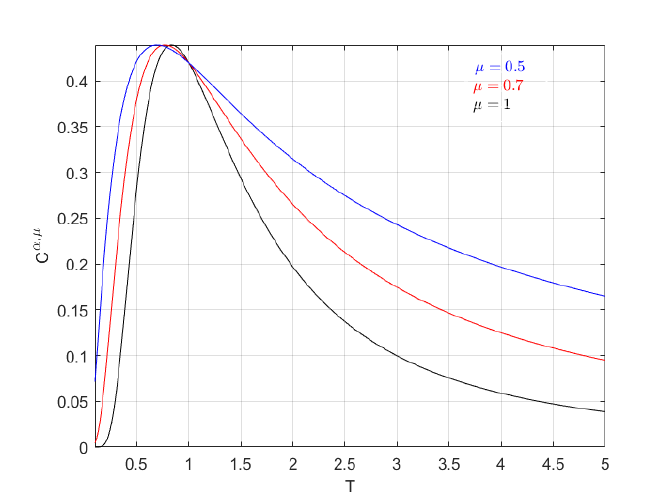
Figure 4. Graph shows the fractal heat capacity of paramagnetic materials respect to dimension of fractal